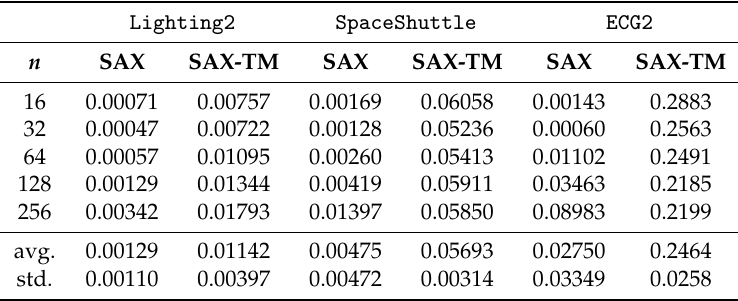
Table 3. Comparison of computation time in seconds between SAX and SAX-TM for the three datasets ( Lighting2 , SpaceShuttle , ECG2 ) of length 637, 5000, and 21,600, respectively. Lighting2